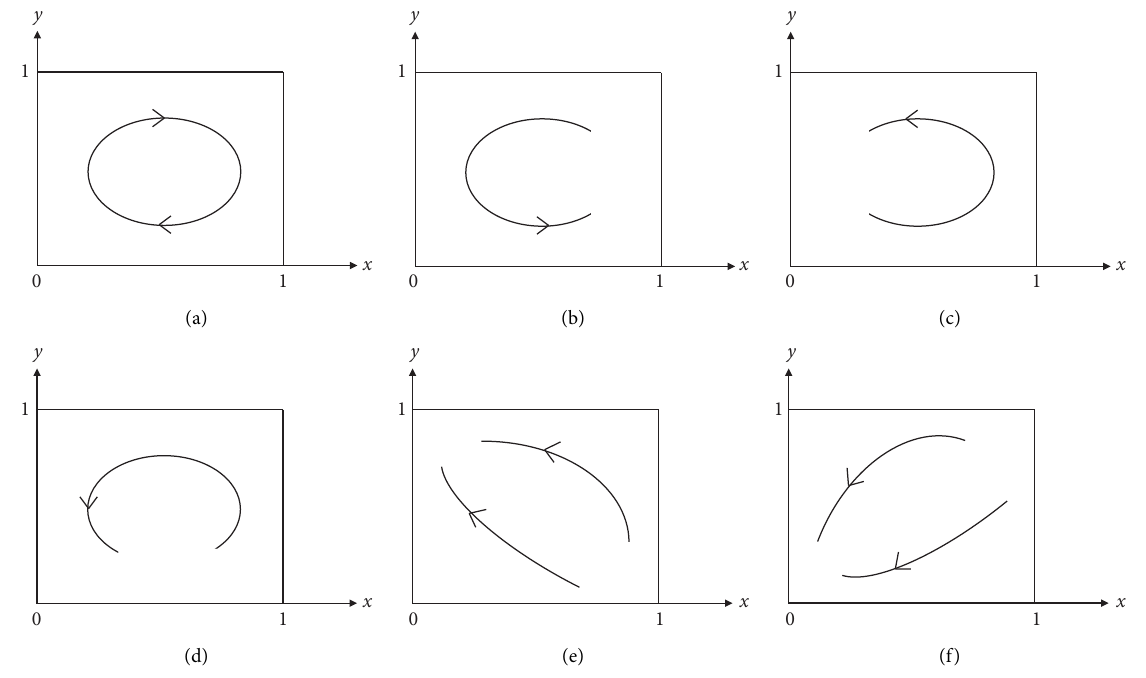
Figure 2: Local stability of the evolutionary game between the governments and